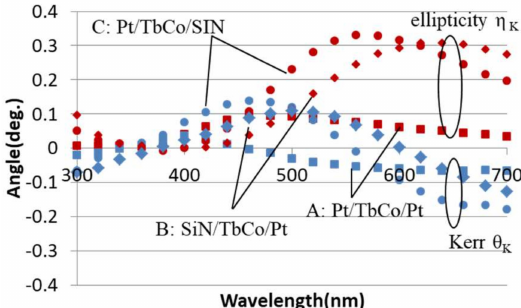
Figure 3. Kerr spectra of Kerr rotation ( θ K ) and ellipticity ( η K ) for sample A: Pt(3 nm)/TbCo(6 nm)/Pt(3 nm), sample B: Si 3 N 4 (10 nm)/TbCo(6 nm)/Pt(3 nm), and sample C: Pt(3 nm)/TbCo (6 nm)/Si 3 N 4 (10 nm). Blue and red dots show θ K and η K , respectively.